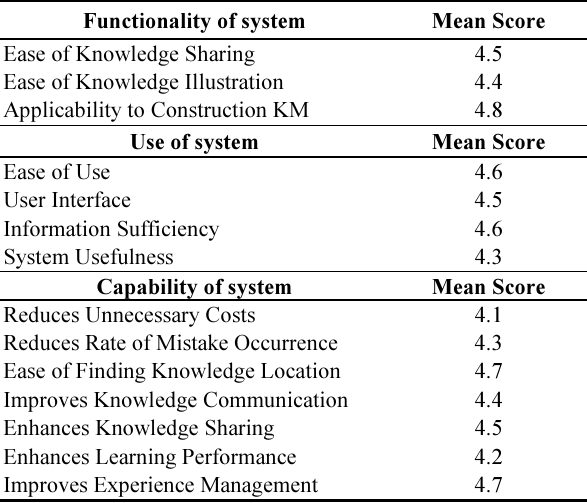
Table 3. System evaluation